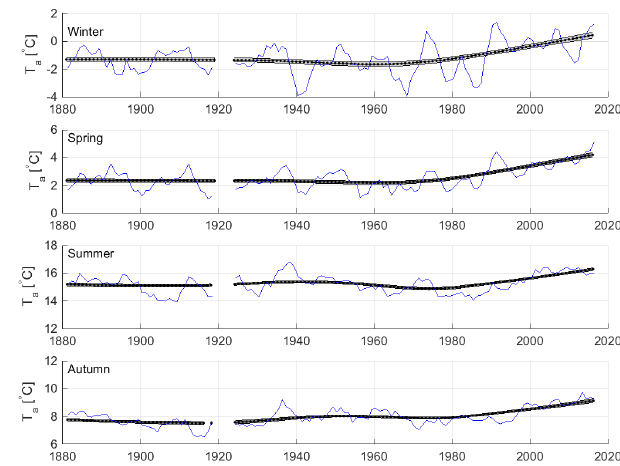
Figure 4. Average seasonal air temperatures at Utö during 1881– 2016. Winter: December, January, February; spring: March, April, May; summer: June, July, August; autumn: September, October, November. As in Fig. 2, the black line represents DLM-calculated trend, the gray area represents error for the trend, and the blue line represents the 5-year running average.